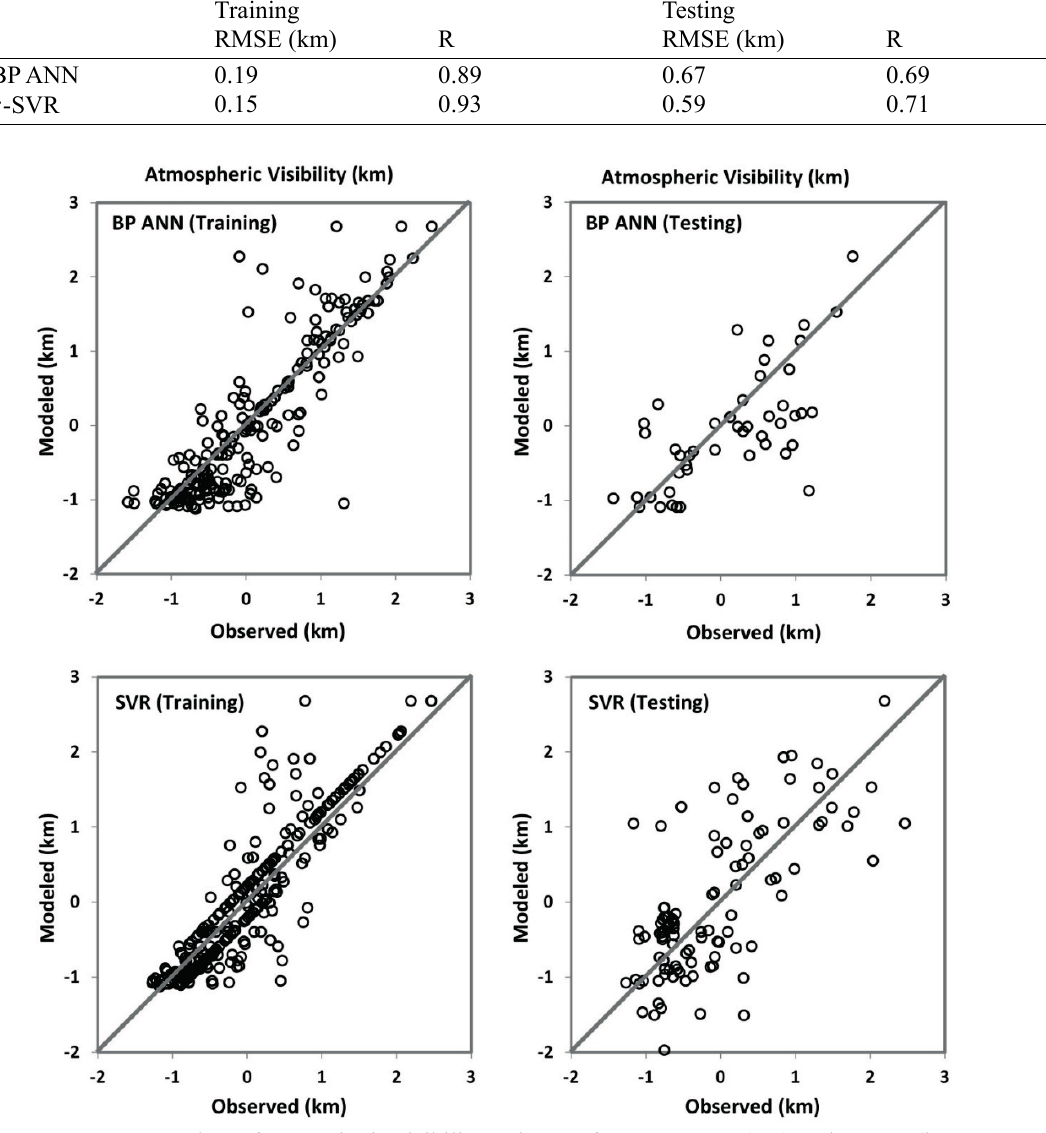
-SVR (bottom) models 𝜀𝜀